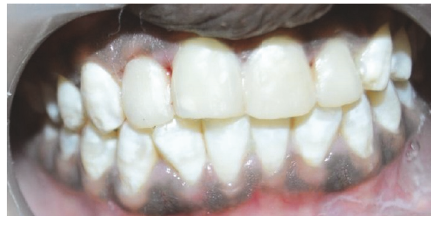
Figure 6: 2-year